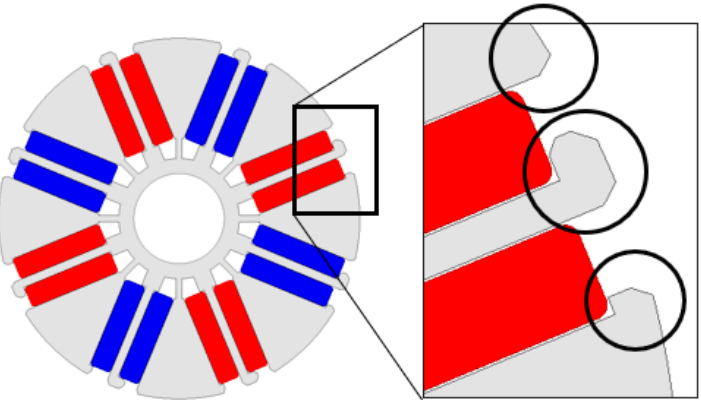
Figure 7. Results of the first 2D finite element analysis at washing and dehydrating load.